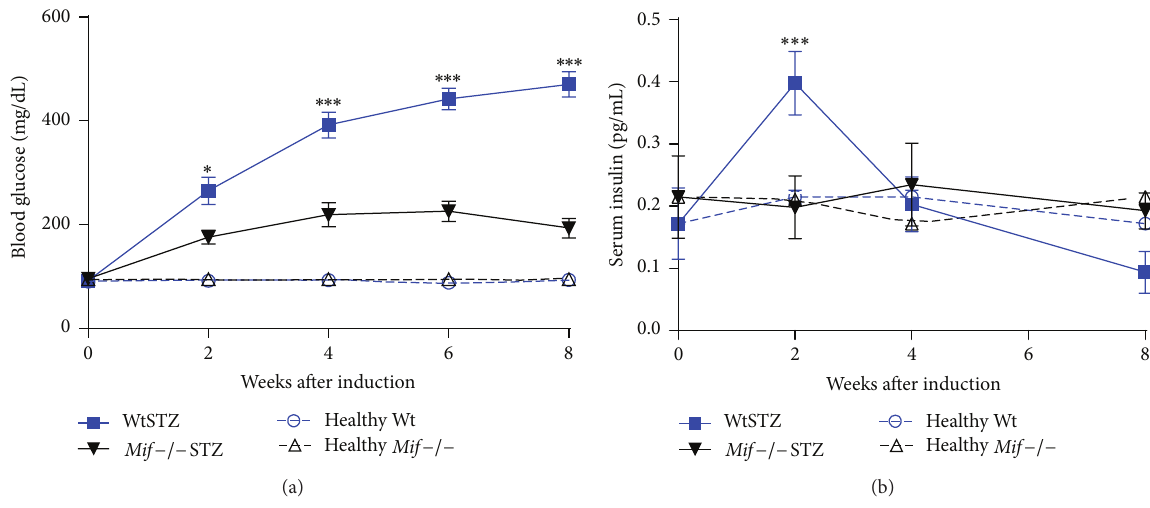
Figure 1: Mif − / − mice developed less severe hyperglycemia than Wt mice after type 1 diabetes mellitus induction. Blood glucose (every 2 weeks) (a) and serum insulin (0, 2,, and 8 weeks) (b) levels were monitored as described in Section 2 in Wt ( ◼ ) and Mif − / − ( 󳶃 ) mice after STZ administration; as controls, healthy Wt ( I ) or healthy Mif − / − ( Δ ) mice were plotted as well. All data are representative of three independent experiments and are expressed as the means ± SE ( n = at least 5–7 animals per group/time point). ∗ 𝑝 < 0.05 , ∗∗∗ 𝑝 < 0.001 , GraphPad Prism software